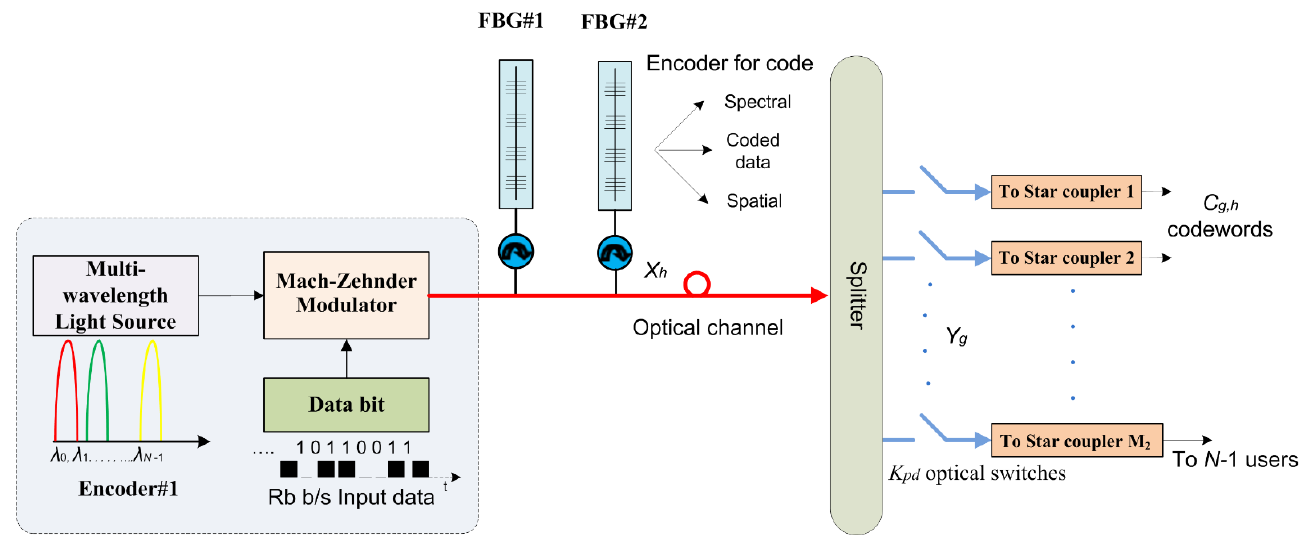
Figure 1. Transmitter structure of the 2D balanced incomplete block design (BIBD) OCDMA system.